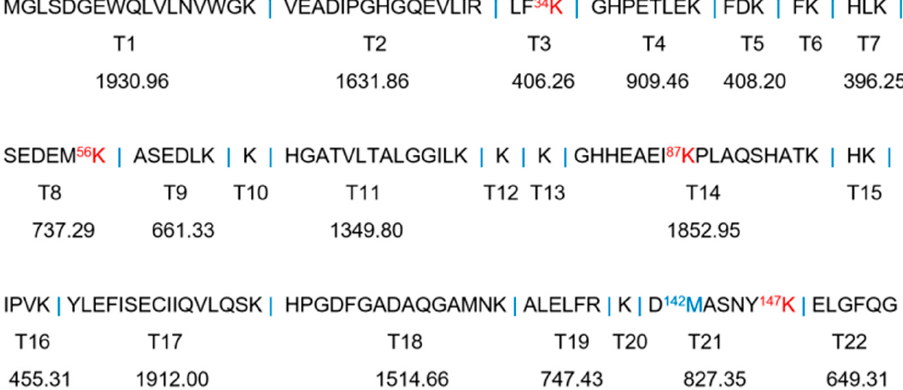
Figure 3. The amino acid sequence of HMb and the expected peptide fragments (T1–T22) by trypsin digestion. The molecular weight of each peptide fragment and the four identified Lys residues are labeled.